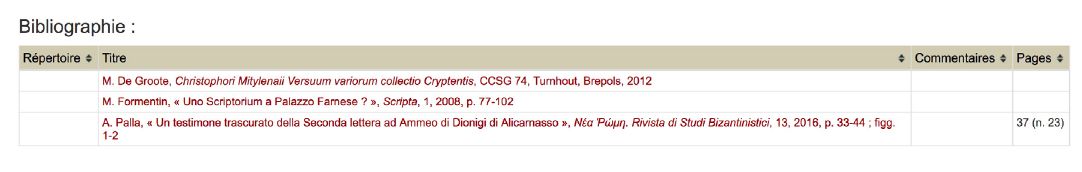
Figure 8. Bibliography on Pinakes for GA 2042 (dikyton